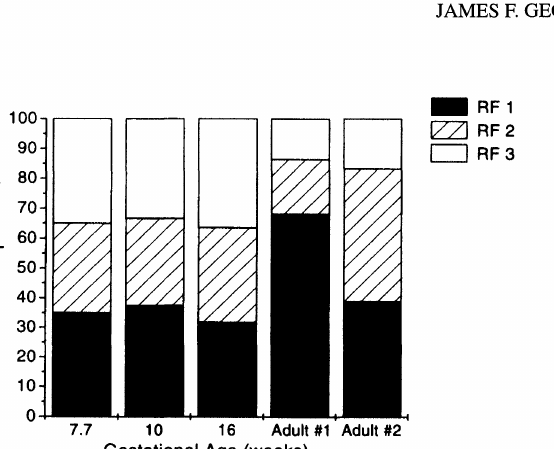
Reading-frame utilization in TCRB DJ sequences obtained from genomic DNA isolated from fetal and adult thy- muses. The frequency of sequences wherein a J gene segment has been spliced into D-region segment in RF is depicted as a black column. Rearrangements in RF 2 are shown in cross-hatch and rearrangements in RF 3 are shown in white. The numerator in all cases is the total number of unique transcripts sequenced from the thymus sample defined on the